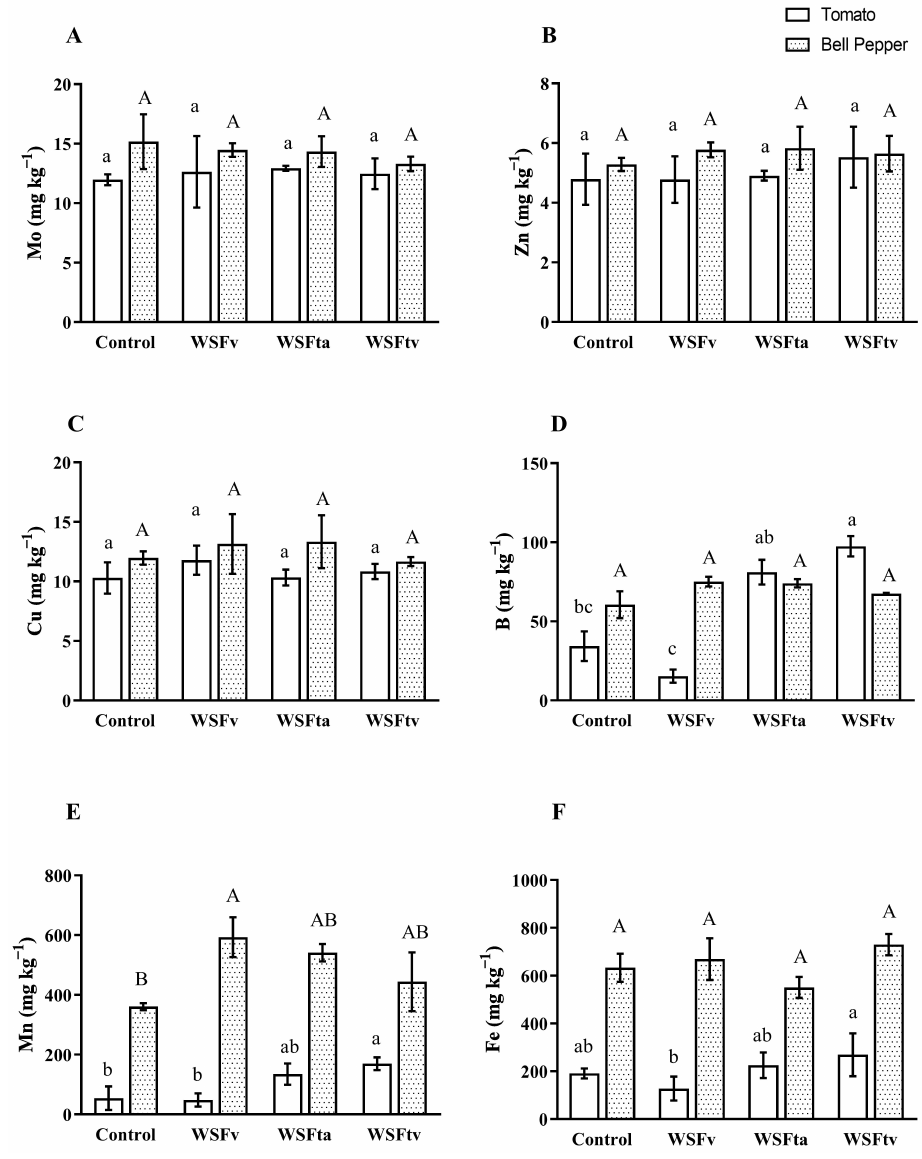
Figure 4. Micronutrient content ( A ): Molybdenum (Mo), ( B ): Zinc (Zn), ( C ): Copper (Cu), ( D ): Boron (B), ( E ): Manganese (Mn), and ( F ): Iron (Fe)) in Meloidogyne incognita infected tomato and bell pepper plants treated with water-soluble fraction from vermicompost enriched or not with Trichoderma asperellum and T. virens . Lowercase letters and upper letters represent (LSD, p < 0.05) the effects of treatments for tomato plants and bell peppers plants, respectively. Bars represent means ± standard